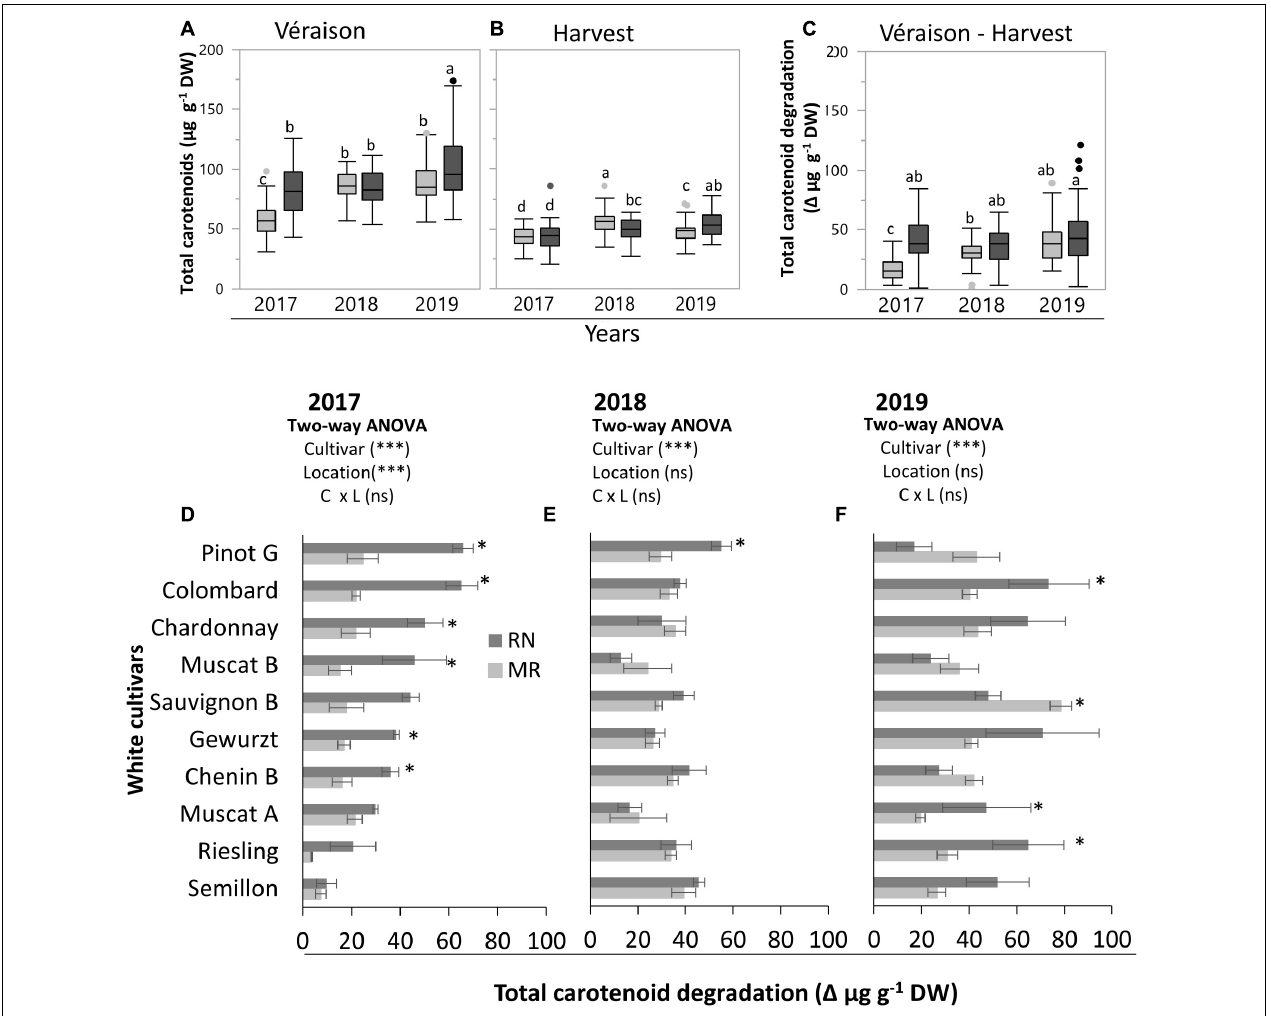
FIGURE 1 | Total carotenoid content at véraison (A) and harvest (B) , and its degradation (C–F) (measured as the difference between véraison and harvest) in white skin berries at the Mitzpe Ramon (MR) and Ramat Negev (RN) vineyards during 2017–2019. Box plots show the difference in the mean of all cultivars ( n = 4 replicates × 10 cultivars) between locations in each season (see Supplementary Table 1 ). Gray and black colors indicate cultivars grown at Mitzpe Ramon and Ramat Negev, respectively. Different lowercase letters indicate significant differences in cultivar means between locations. The bar graphs (D–F) show the effect of location and cultivar on carotenoid degradation in the 2017, 2018, and 2019 seasons. Error bars are standard error ( n = 4). Bar plots followed by ∗ indicate significant differences between locations ( P < 0.05) within the same cultivar based on a non-parametric t -test. ∗∗∗ indicates significant effects ( P < 0.0001) of the main factors in each season based on a two-way ANOVA. C, cultivar; L, location; ns, not